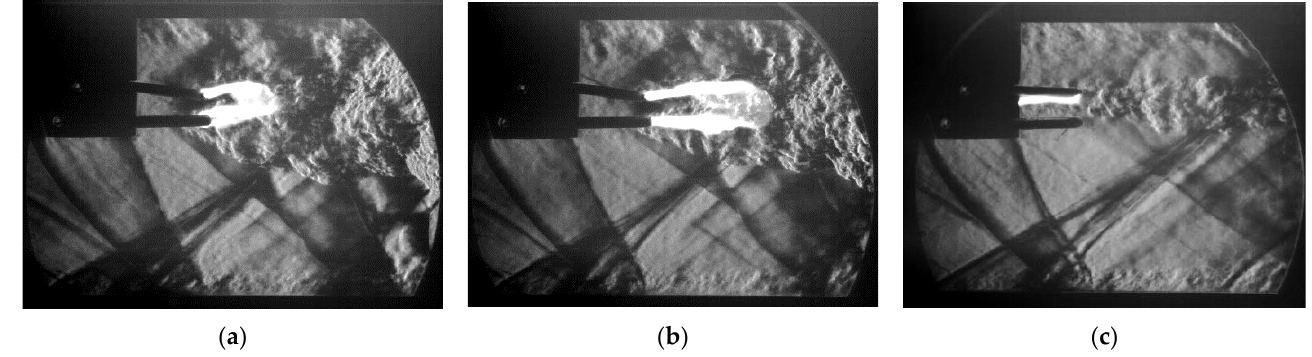
Figure 4. Schlieren visualization of ethylene combustion when testing pylon ver.a: ( a , b ) Current 7.5 A, visible variable discharge length; ( c ) Breakdown on the pylon body.